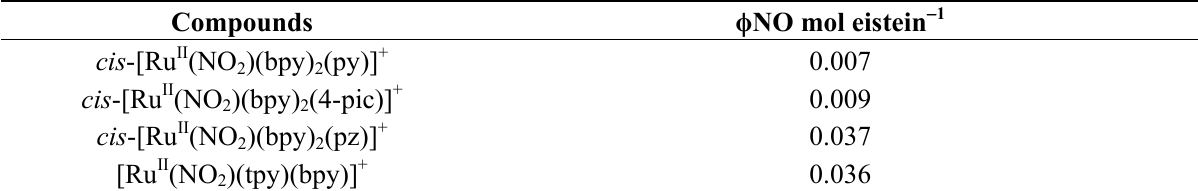
Table 3. Quantum yield ( ϕ NO) values of nitrosyl polypyridine ruthenium complexes after flash photolysis at 355 nm and pH = 7.4 in phosphate buffer